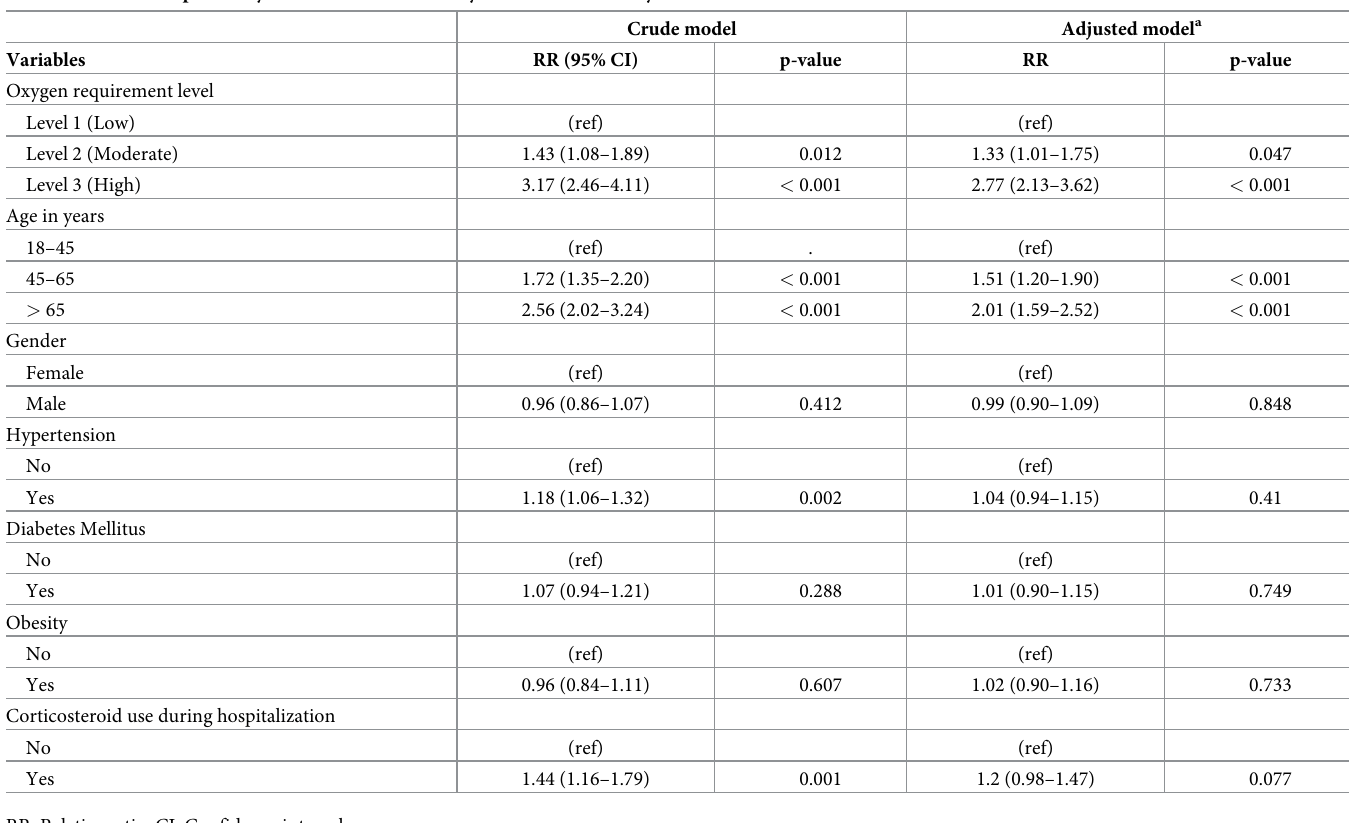
Table 3. Factors independently associated with mortality in multivariate